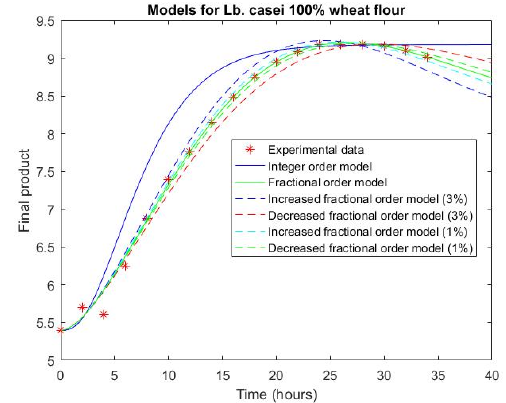
Figure 4. Comparison between simulated and experimental data for experiment 1 using Lactobacillus casei .